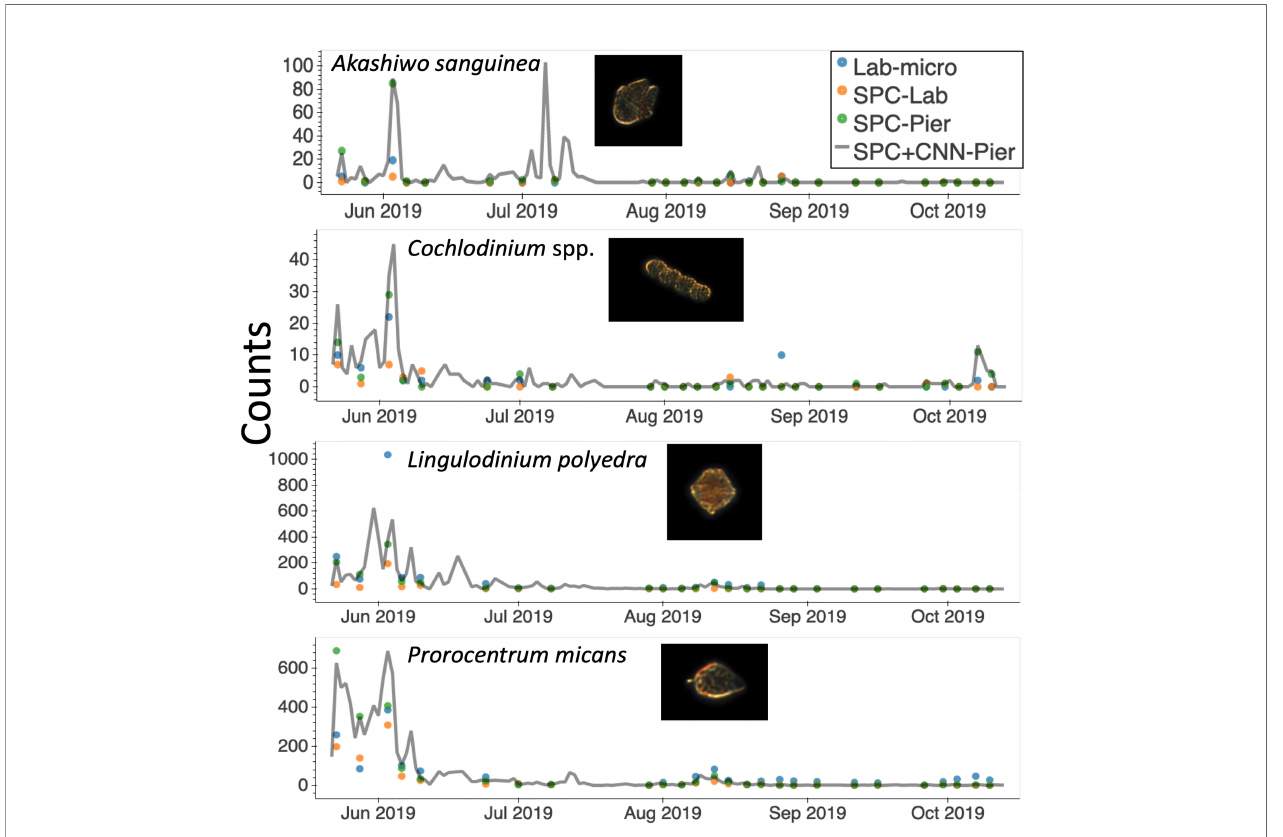
FIGURE 9 | A time series of species presence via “ counts ” or number of observations by the SPC-pier and the SCCOOS monitoring program during 2019. Automated image classi fi cation was used to produce counts on continuous periods. Most of which were not sampled by the SCCOOS program. Plots are shown for only the highly correlated abundant and rare